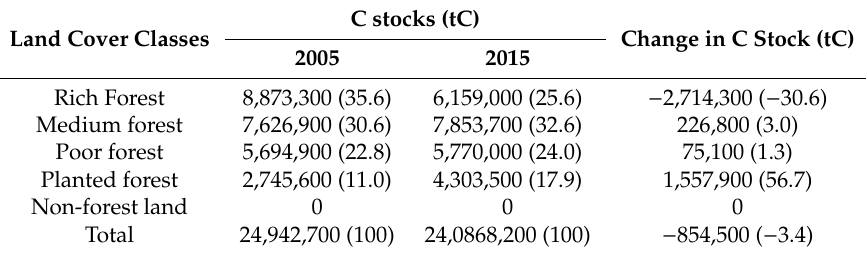
Table 6. Change in forest carbon stock in Qu ả ng Tr ị and Th ừ a Thiên-Hu ế Provinces from 2005 to 2015. Unit of carbon stock is in tons (tC), and the percentage is indicated in the parenthesis.